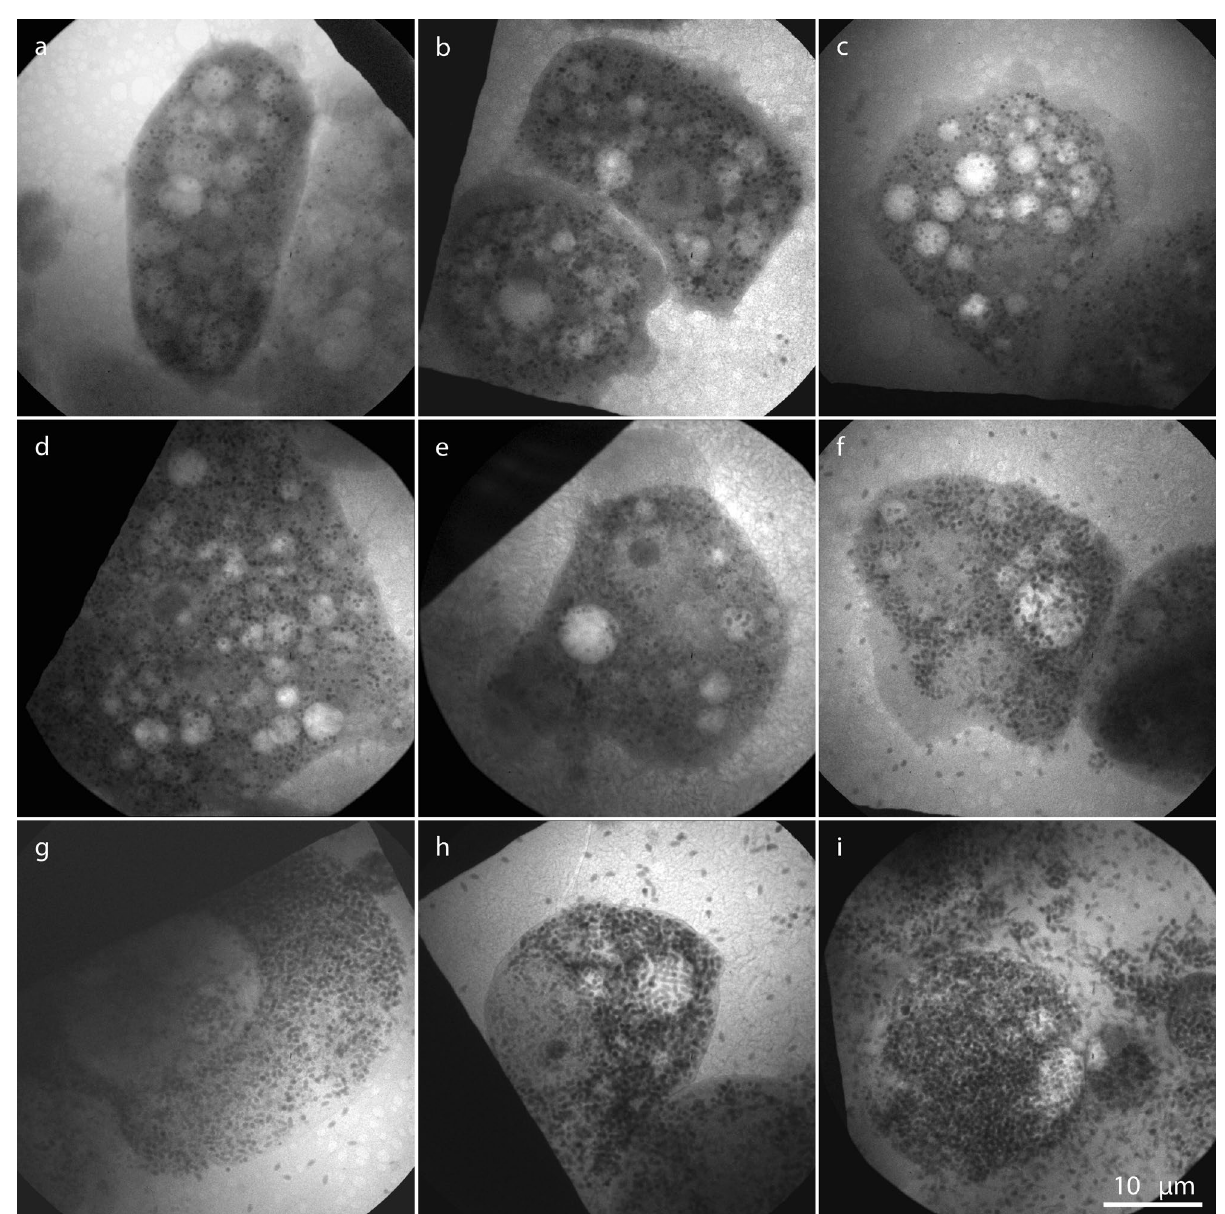
Figure 3. Virus infection series, ranging from non-infected cells to cells 70 hpi, visualized using laboratory cryogenic X-ray microscopy. ( a ) Non-infected amoeba (n = 5) that is included for comparison and has been treated identically as the infected amoebae 30 hpi aside from not adding the virus. The infection times in the displayed images are ( b ) 6 h (n = 5), ( c ) 12 h (n = 6), ( d ) 15 h (n = 5), ( e ) 18 h (n = 6), ( f ) 24 h (n = 5), ( g ) 30 h (n = 5), ( h ) 54 h (n = 5) and ( i ) 70 h (n = 4), respectively. In the images up to 15 hpi ( a – d ) no clearly distinguishable virions were detected. At 18 hpi ( e ) a few virions can be seen, e.g. in a vacuole in the right part of the cell as well as to the lower left of the nucleus. At longer infection times ( f – i ) the virions take up an increasing part of the cell volume, as well as the surrounding medium, until they appear densely packed throughout the cell. Possible viral factories, like the one marked in Fig. 2, can be seen close to the nuclei at 18–30 hpi ( e – g ). The vacuolated structure of the healthy cells seems to disappear as the production of virions takes off, while the cell nucleus can be seen in all images up to 54 hpi ( a – h ). Scale bar is 10 µm and valid for all